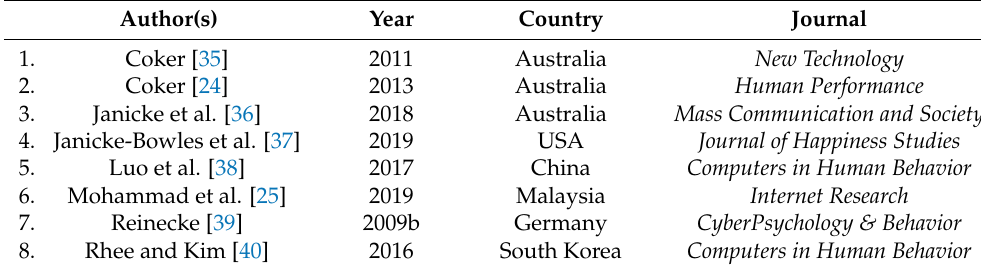
Table 1. Summary of Reviewed Articles.